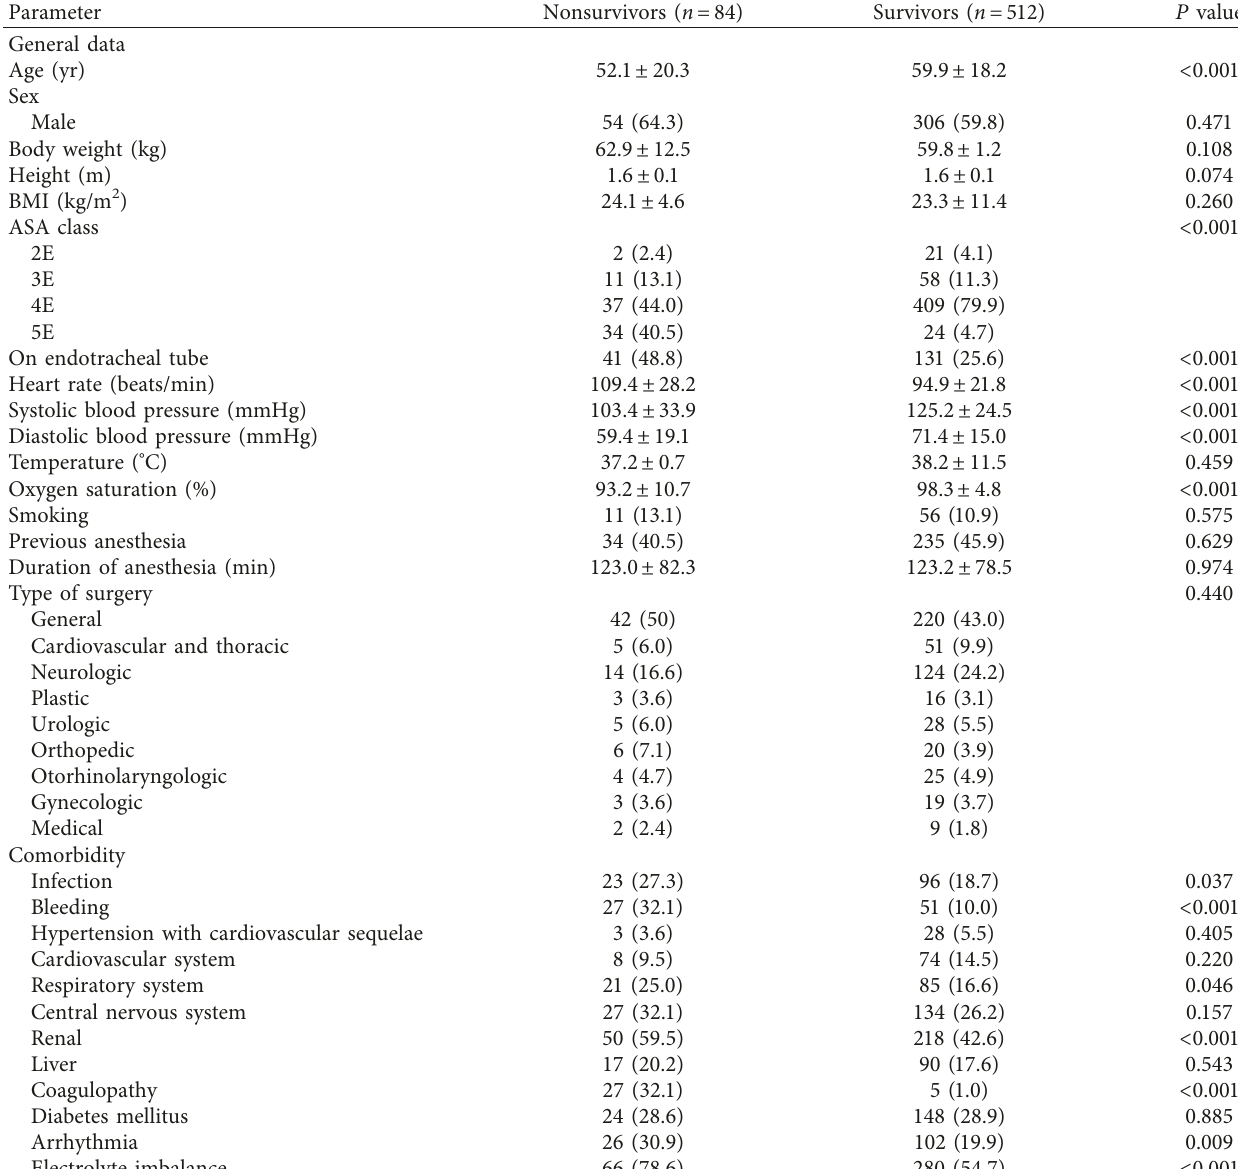
Table 2: Patient demographic and clinical data of the Training group ( n �